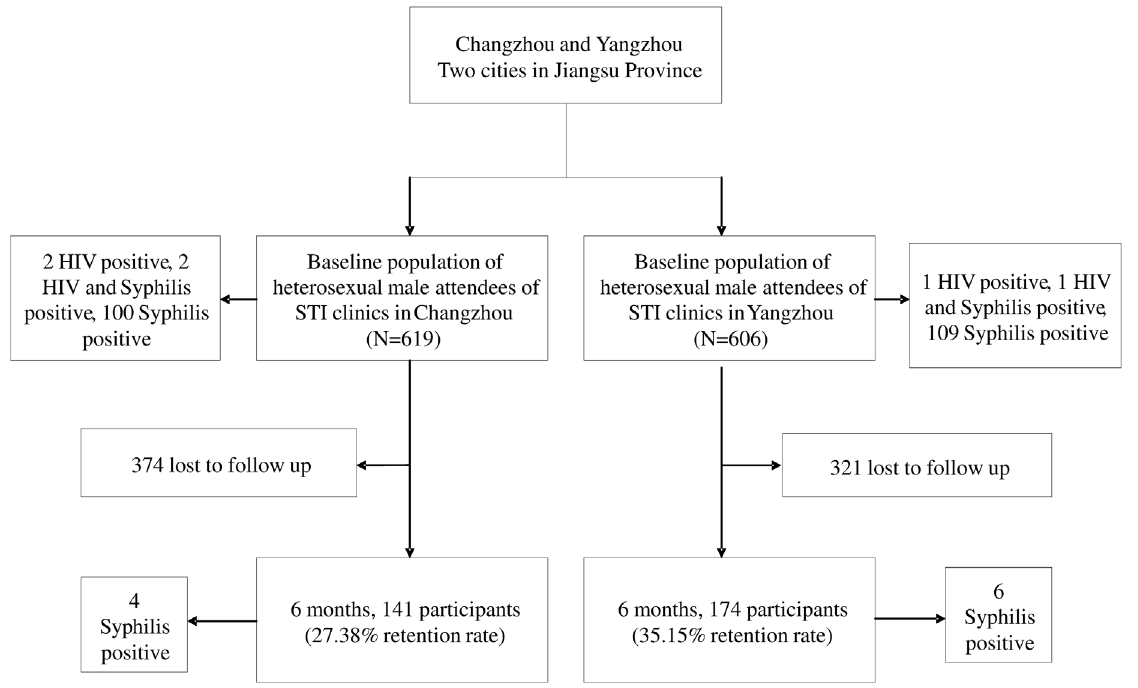
Figure 1. Flow chart of the recruitment of the cohort among heterosexual male attendees of STI clinics (MSC) in Yangzhou and Changzhou cities of Jiangsu Province, China, 2009. (n=1225).